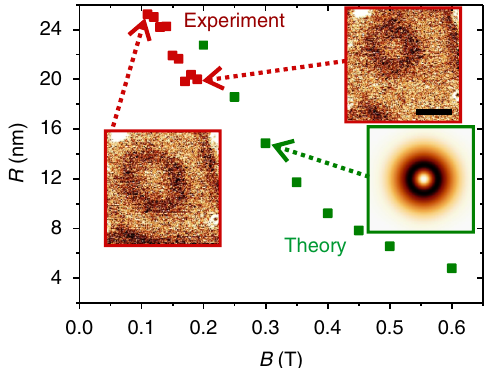
Fig. 4 Magnetic fi eld dependency of skyrmion radius. Dependency of the skyrmion radius with the magnetic fi eld — Green dots correspond to to radius extracted from Monte Carlo simulations — Red dots are extracted from experiments realized with a bare tungsten tip — inset red frame: two example of the experimental d I /d U map used to extract this pro fi le showing a single skyrmion through the TAMR effect — the left one was recorded at 120 mT — the right one at 190 mT (60 × 60 nm, I = 1 nA, U = − 220 mV, Δ U = 50 mV) — inset green frame: Theoretical d I /d U TAMR contrast of rms an isolated skyrmion at 300 mT, scale bar is 20